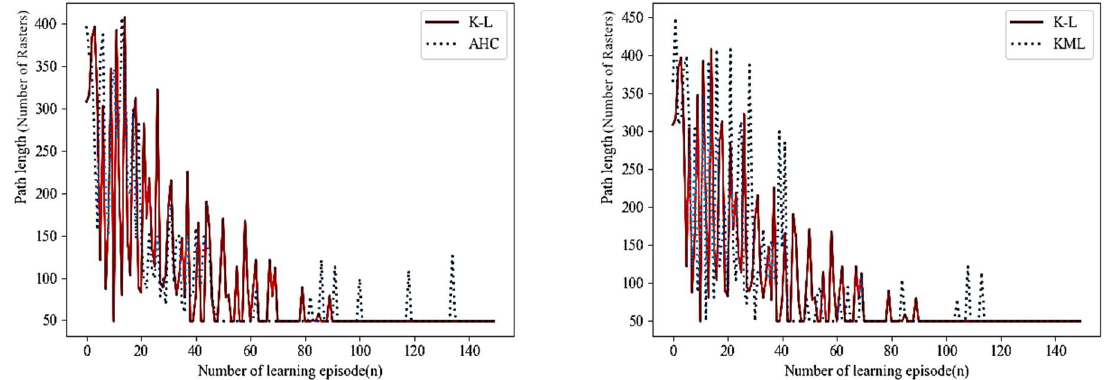
Figure 9. Comparison chart of K-L algorithm in convergence time.